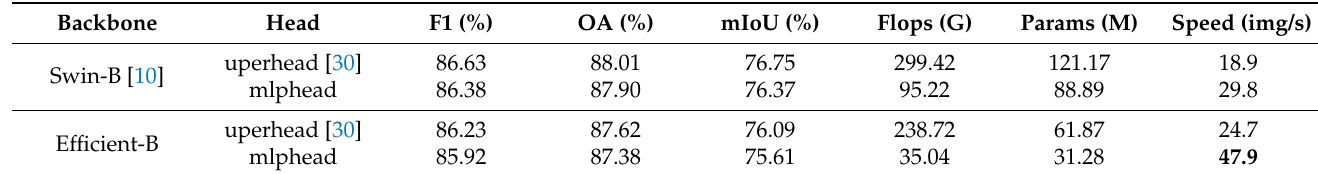
Table 7. Inference speed evaluation on Swin-B and